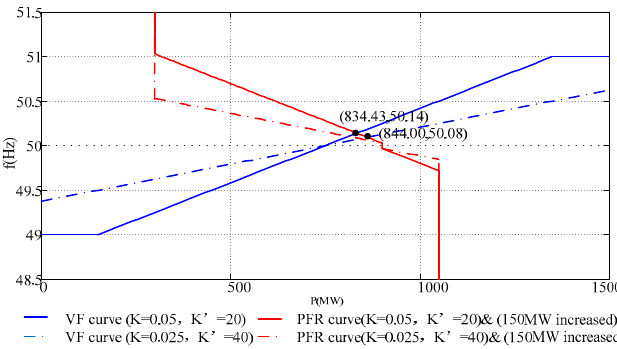
Figure 9. VF curves and PFR curves (K = 0.05, K’ = 20 and K = 0.025, K’ = 40). Table 4. The self-regulation proportions of power fluctuations (di ff erent K and